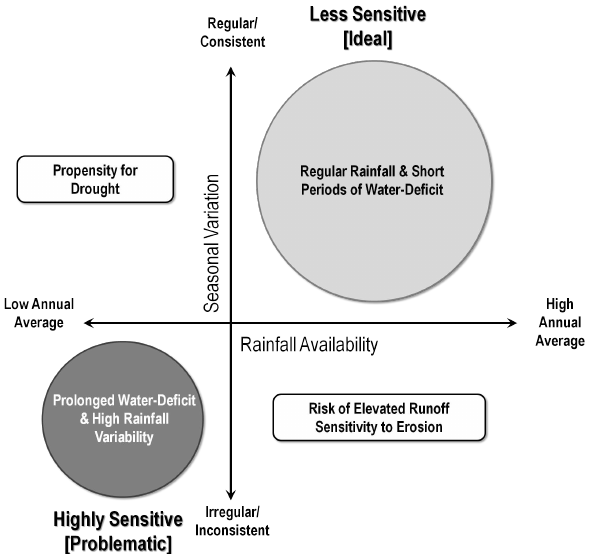
Fig. 4. Conceptual matrix of site-specific sensitivity to climatic fac- tors in the context of rehabilitation development.